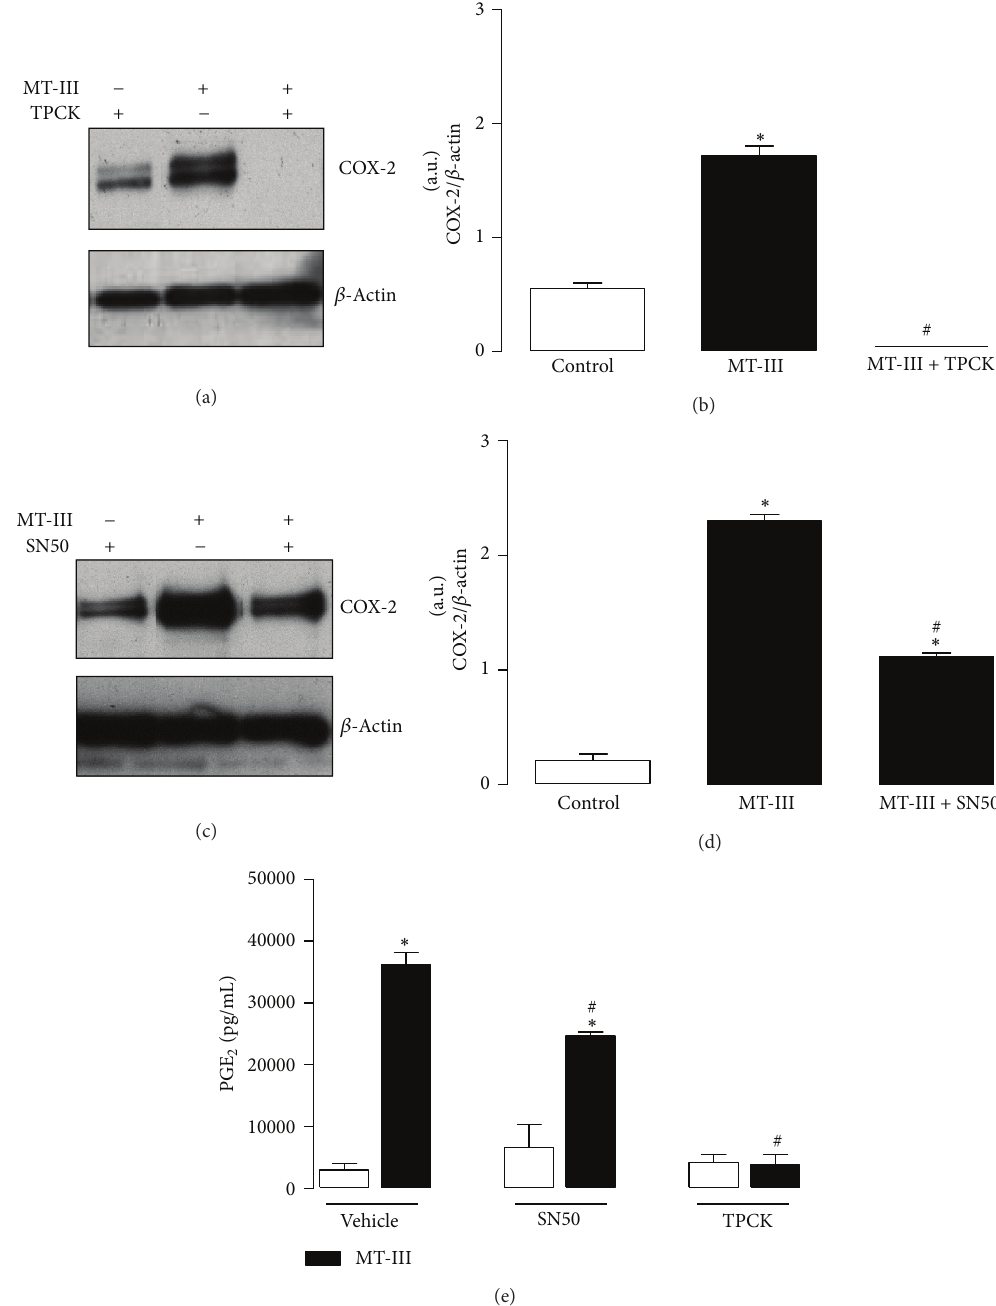
Figure 2: NF- 𝜅 B is involved in COX-2 expression and PGE 2 release induced by MT-III in macrophages. Resident peritoneal macrophages ( 1 × 10 6 cells) were pretreated with TPCK (2.5 𝜇 M) or SN50 (50 𝜇 g/mL) and incubated during 4.5 h with MT-III (0.4 𝜇 M). (a, c) Western blotting of COX-2 and 𝛽 -actin (loading control) of cells pretreated with SN50 or TPCK. (b, d) Densitometric analysis of immunoreactive COX-2 band intensities. (e) PGE 2 was quantified in culture supernatants by enzyme immunoassay (see Section 2). Results are expressed as mean ± SEM from 3 experiments. ∗ 𝑃 < 0.05 as compared with control